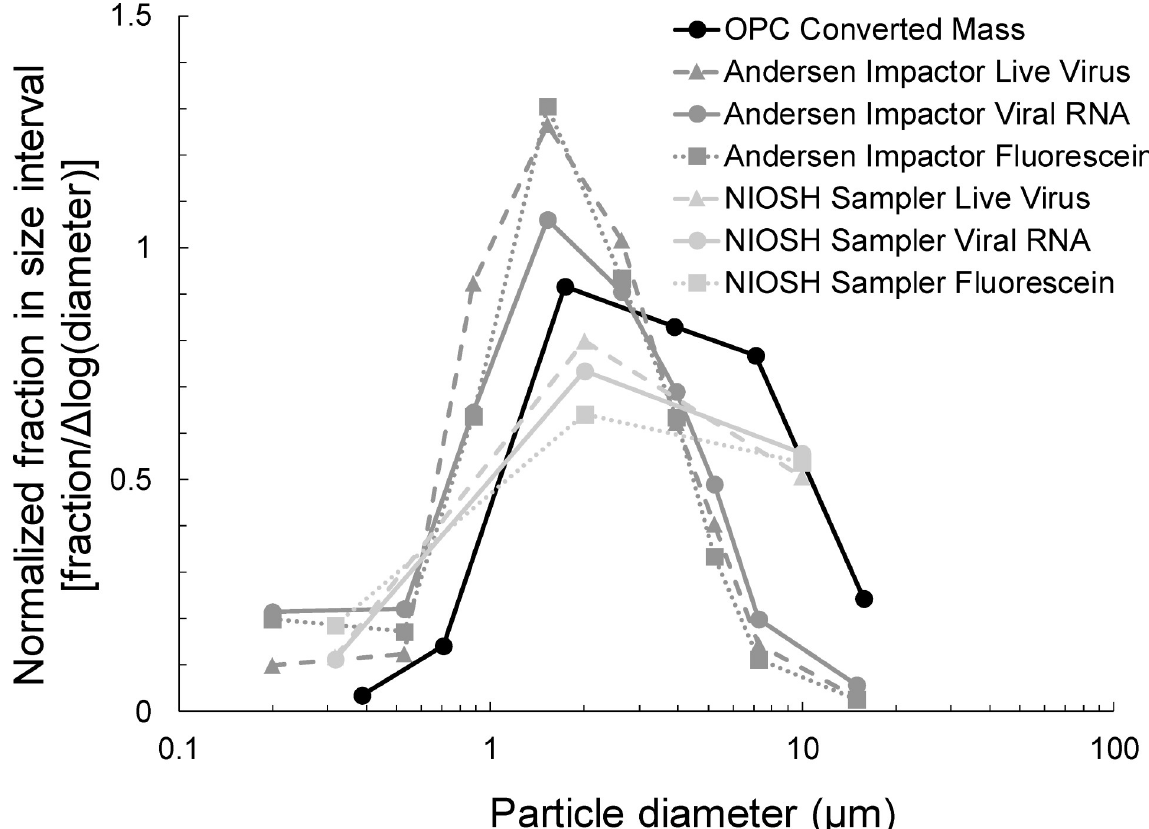
Fig 5. Mean fractional size distributions normalized by the width of the size interval on a logarithmic scale for the size distribution by mass calculated from optical particle counter data and for live virus, viral RNA, and fluorescein sampled with the Andersen cascade impactor and the NIOSH Cyclone Bioaerosol Sampler during tests with MS2